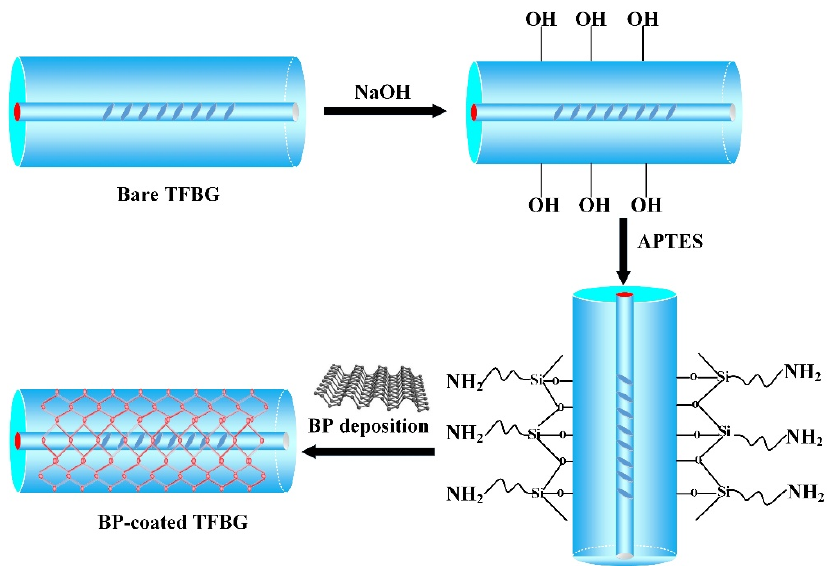
Figure 3. The flow diagram of the functionalized fiber surface and the deposition of black phosphorus (BP) onto weakly tilted fiber Bragg grating WTFBG